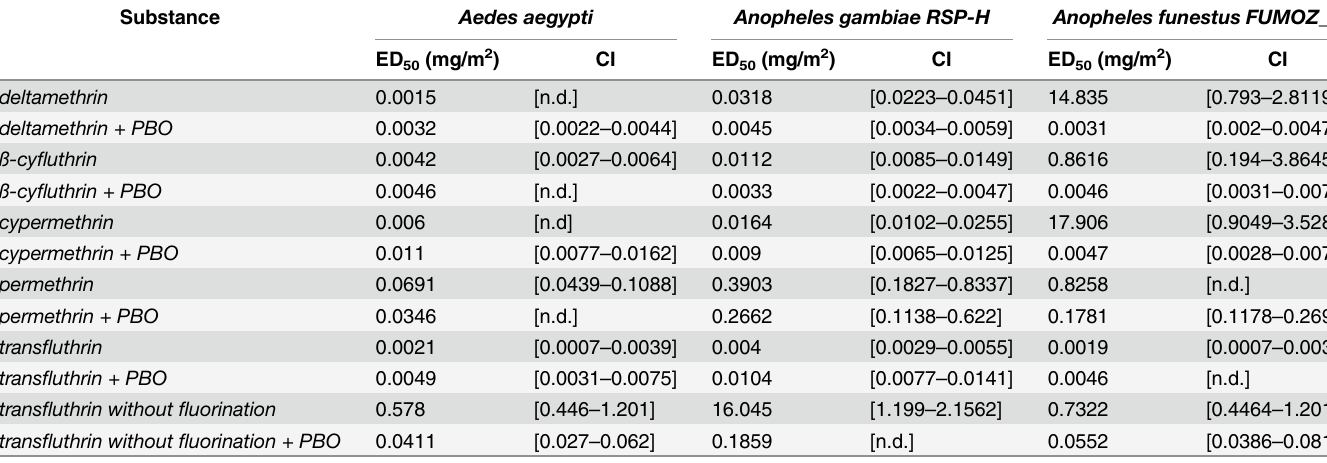
Table 1. ED 50 values with confidence intervals